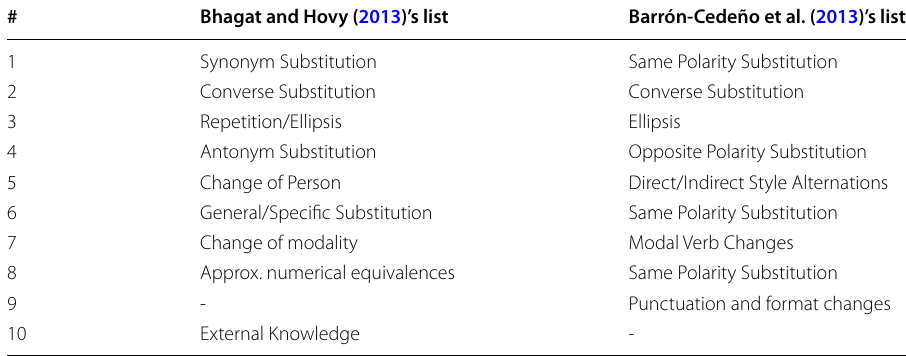
Table 2 Partial mapping of paraphrase types between (Bhagat and Hovy 2013) and (Barrón-Cedeño et al.